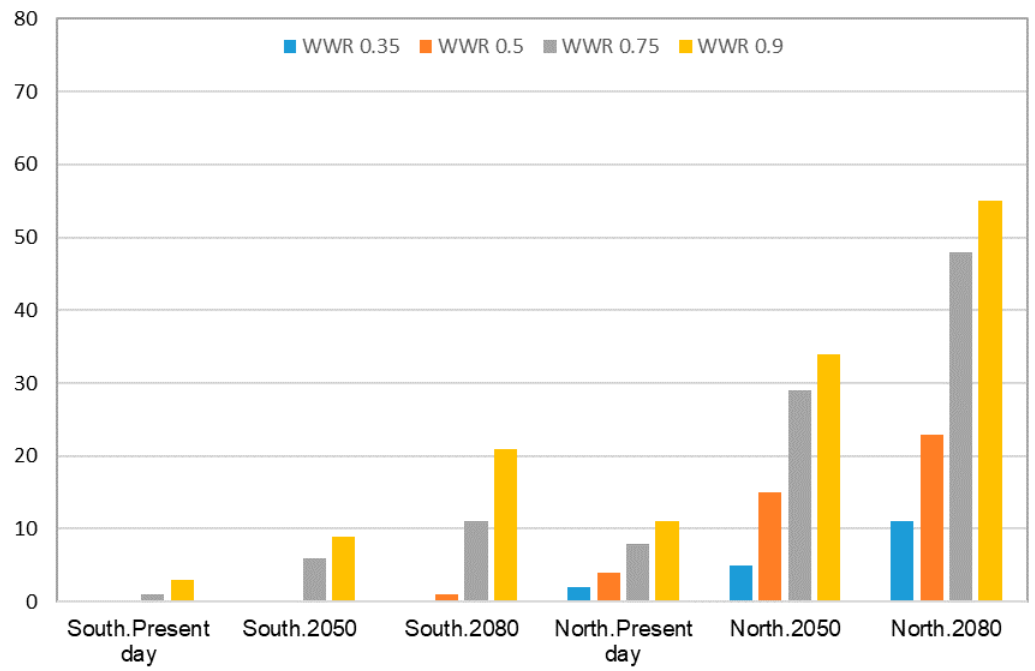
Figure 10. Hours of temperature exceeding 26 °C during the occupied period based on CIBSE TM 59 (Tight building).